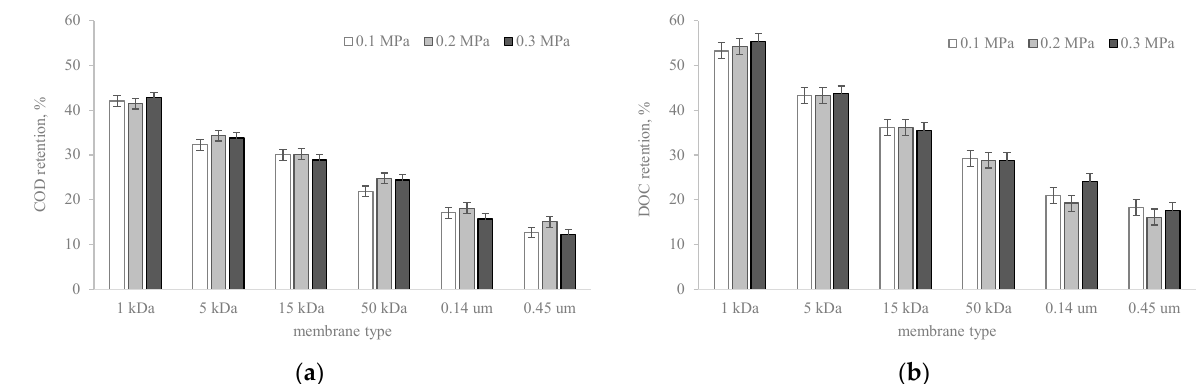
Figure 4. Influence of transmembrane pressure on COD ( a ) and, DOC ( b ) retention.